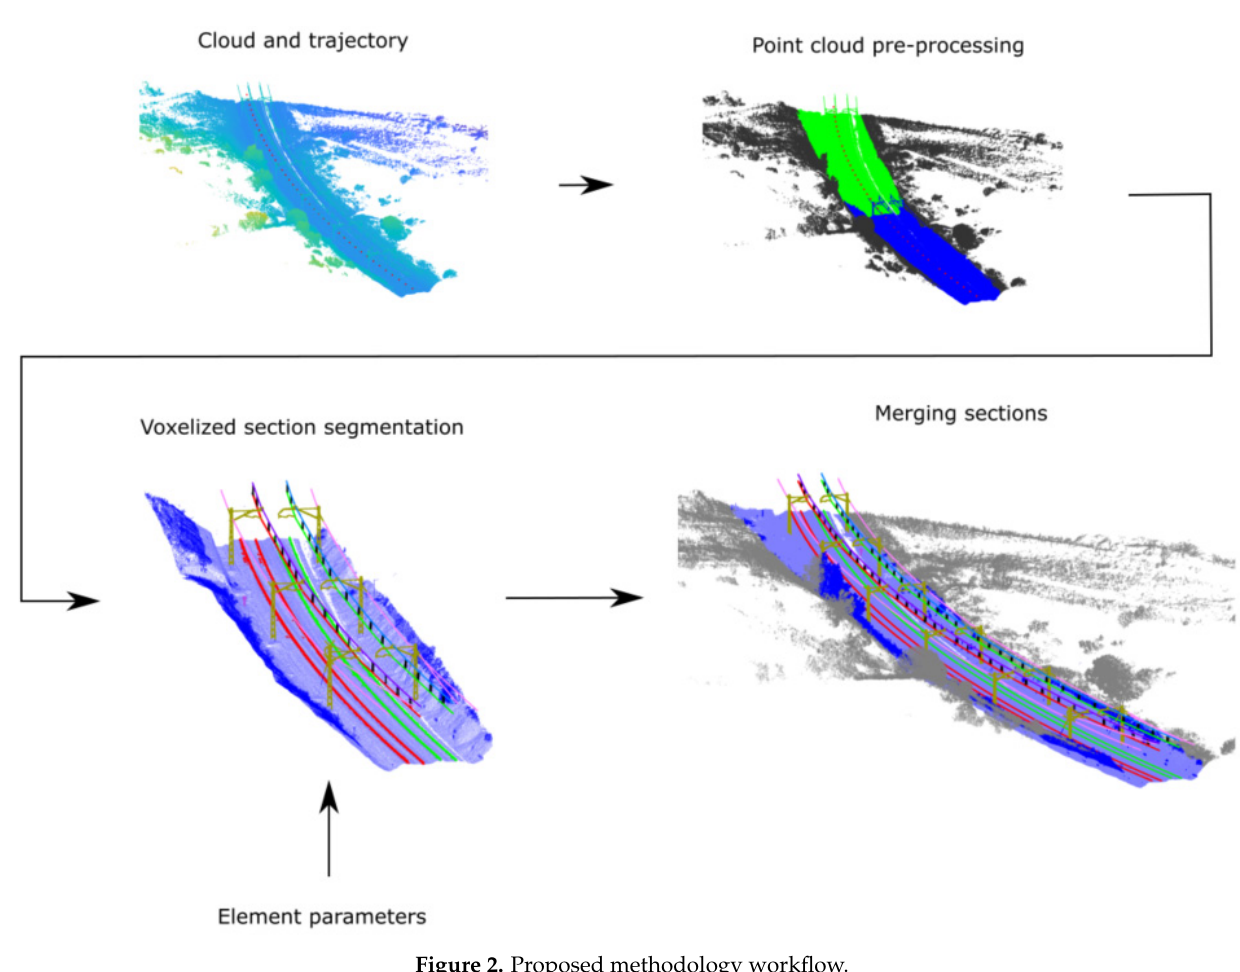
Figure 2. Proposed methodology workflow.